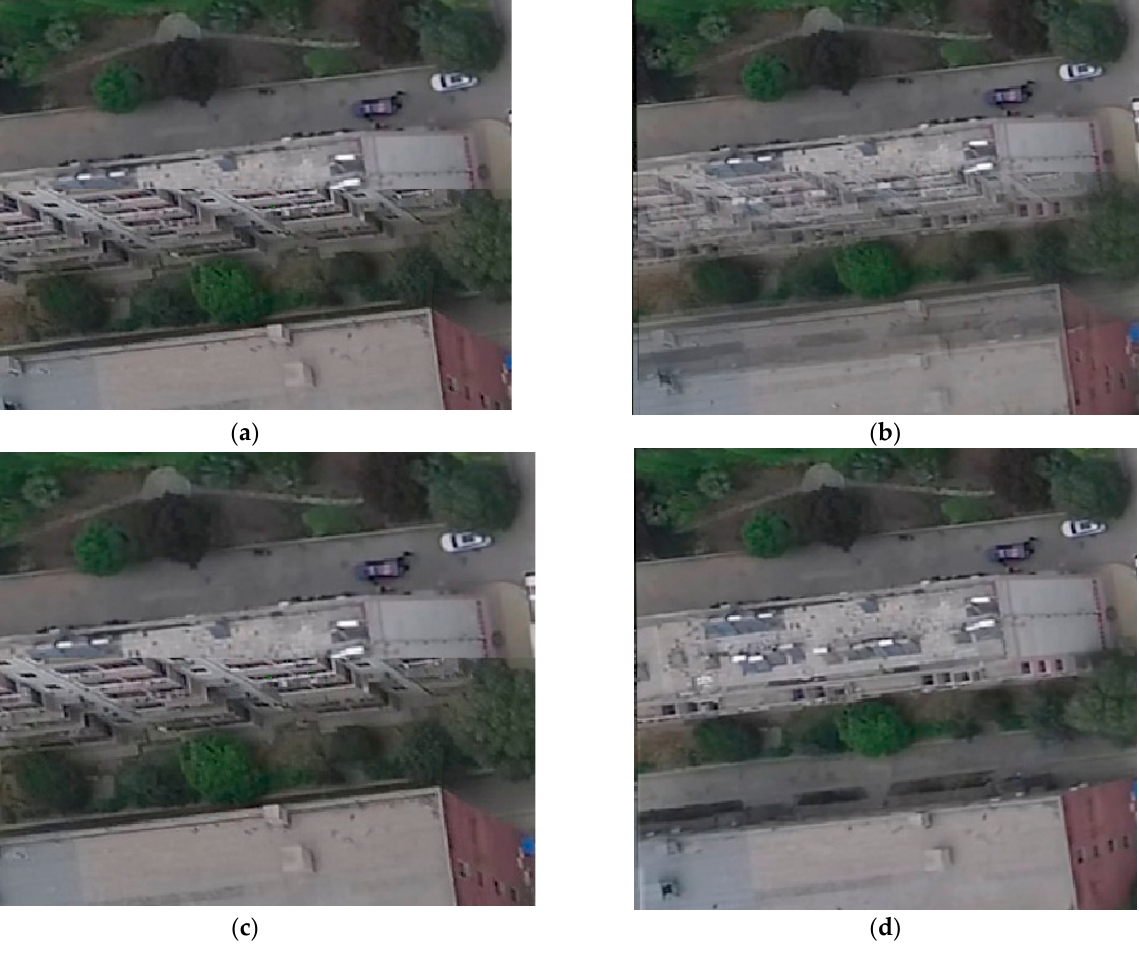
Figure 14. Compositing comparison of seam in panorama using different fusion methods. ( a ) Simple coverage. ( b ) Weighted fusion. ( c ) Weight substitution. ( d ) Our method.